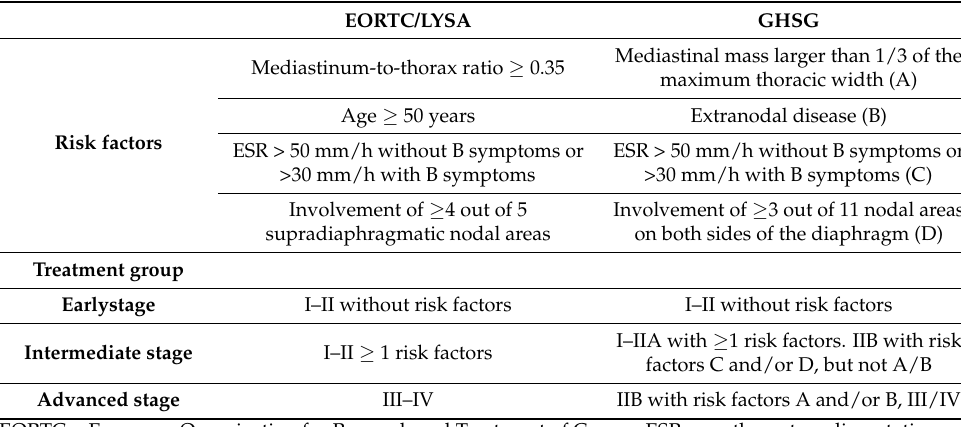
Table 1. EORTC/LYSA and GHSG HL risk group classifications.